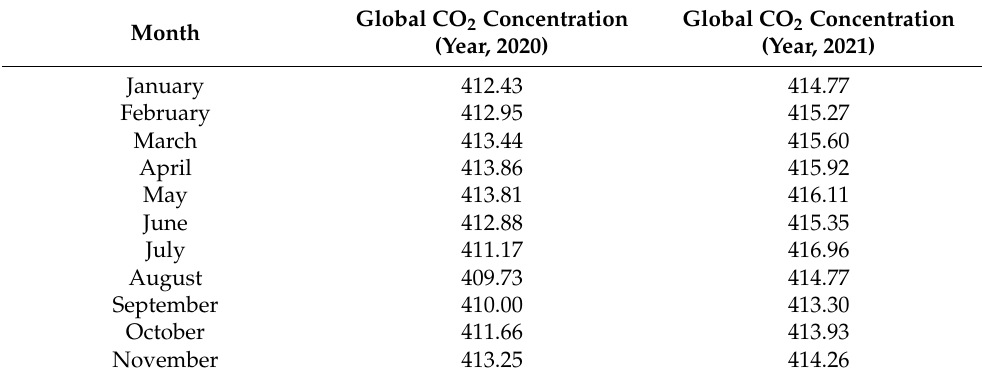
Table 1. Global CO 2 concentration in 2020 and 2021. Redrawn from the data of CO 2 daily [2] and NOAA Earth System Research Laboratory, Global Monitoring Division